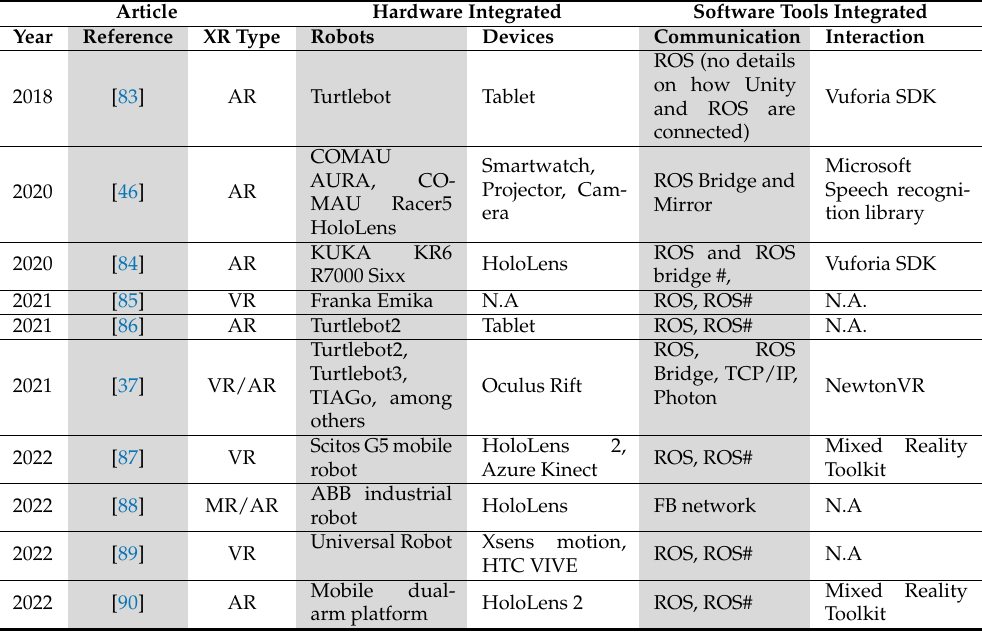
Table 8. Articles presenting XR solutions supporting Human–Robot collaboration tasks. Hardware